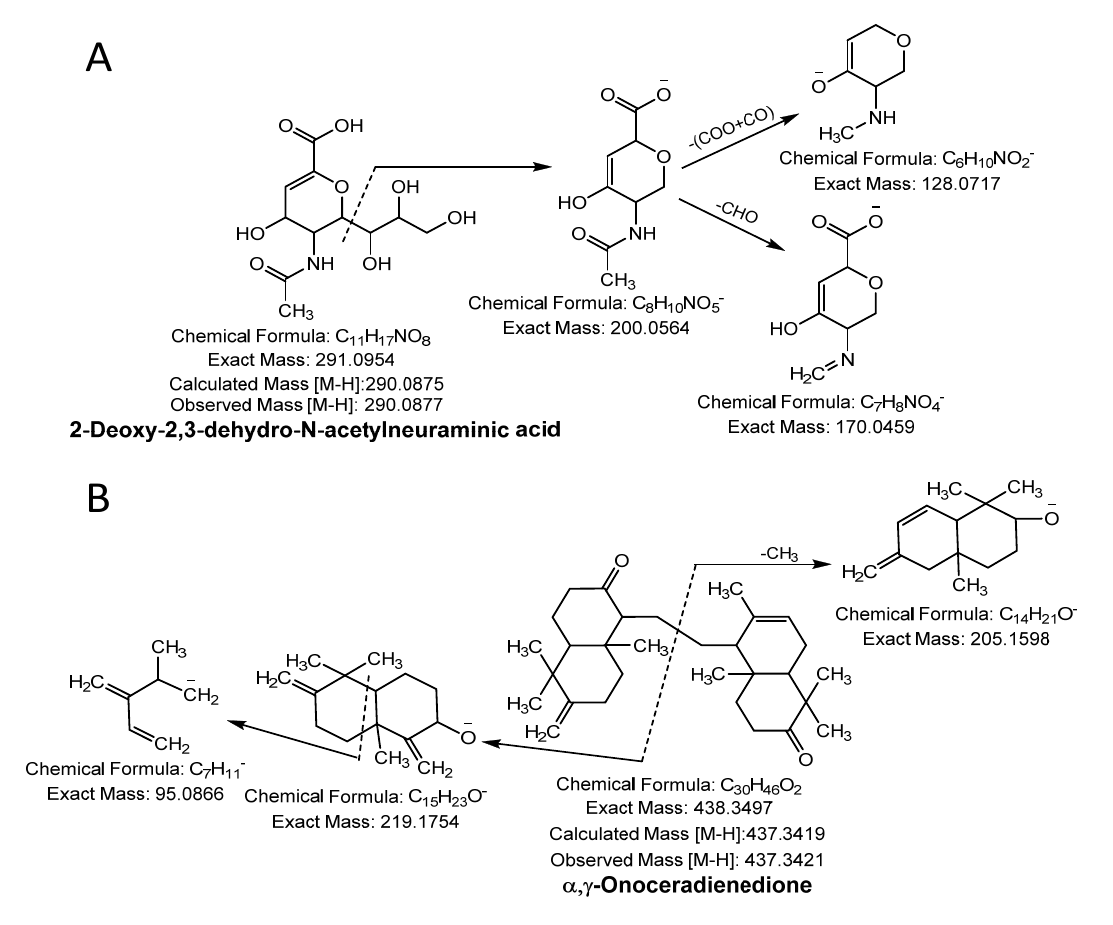
Figure 3. Sialic acid ( A ) and terpenoid ( B ) were identified in NNSE by ESI-MS/MS.